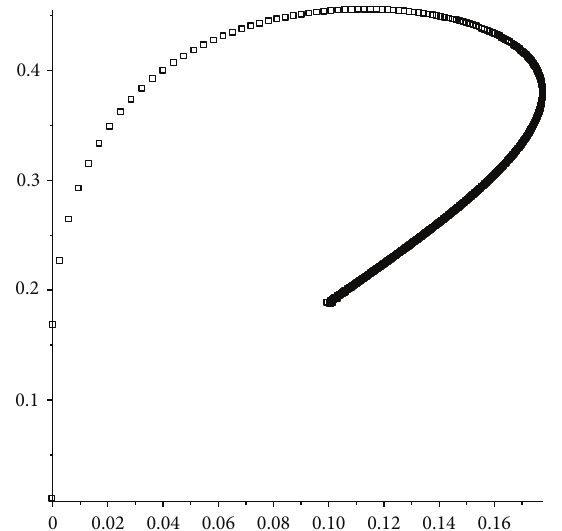
Figure 1: Consider the following system ( 𝑎 Δ 0.4 ℎ,∗ 𝑥)(𝑛ℎ) = 𝑦(𝑏 + 𝑛ℎ) , ( Δ 0.5 𝑦)(𝑛ℎ) = 𝐴𝑥(𝑎 + 𝑛ℎ) , where 𝐴 is given in Example 22, with 𝑏 ℎ,∗ initial conditions: 𝑥 0 = (0, 1) , 𝑥 𝑎 = (0,0.1) , ℎ 0.9 𝐴 − ( 0.9 2 )𝐼 2 ∈ R 2×2 +